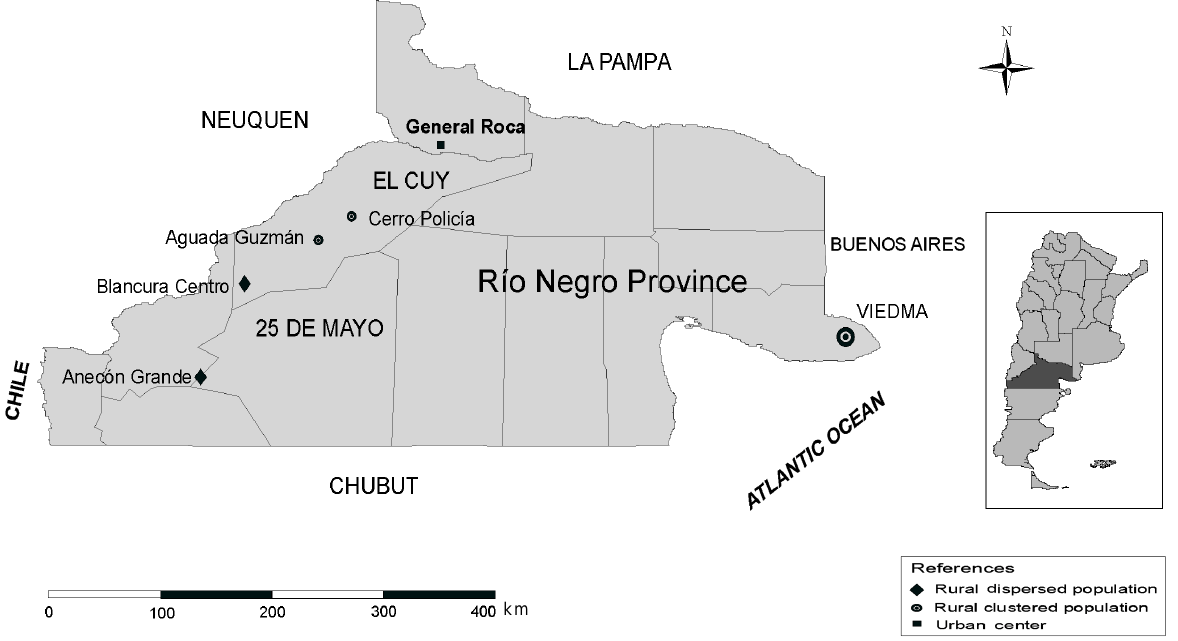
Figure 1 - Map of Río Negro Province, Argentina, showing the geographic location of the populations studied. The map of Argentina, bottom right, indicates the position of this province in the country.